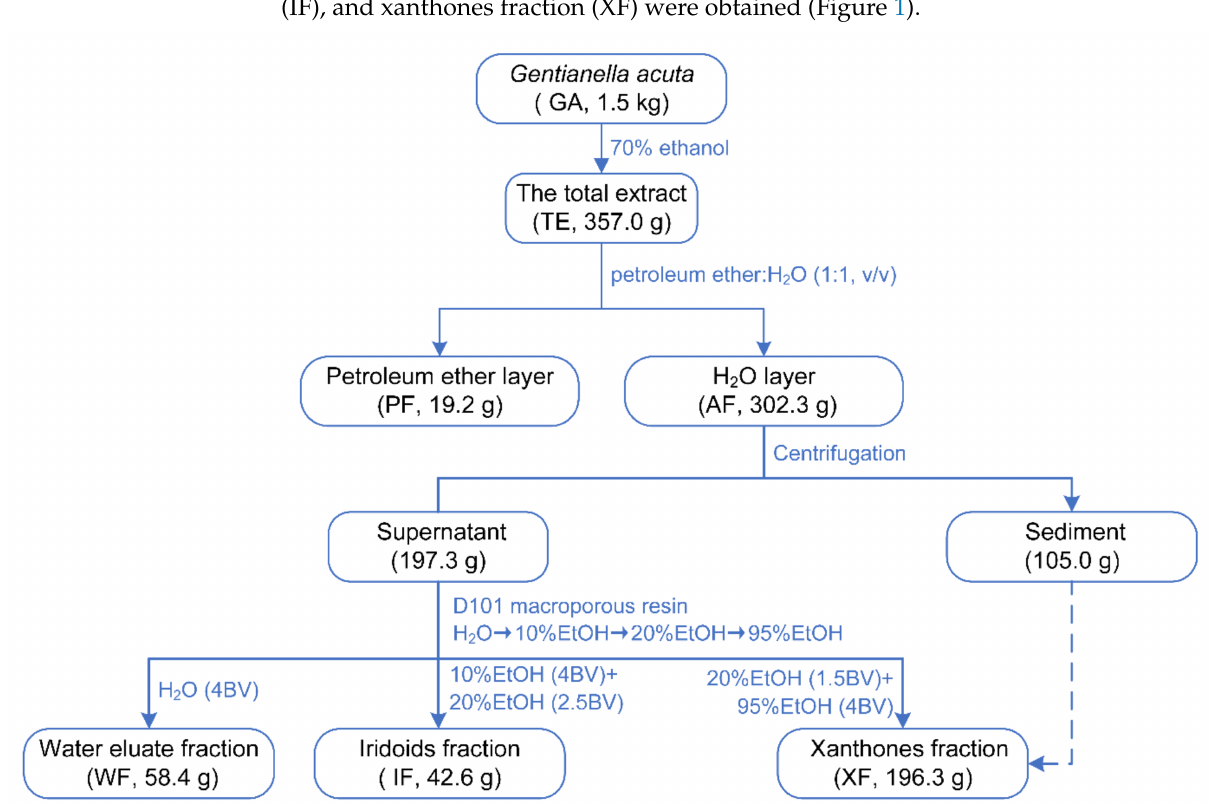
Figure 1. Extraction and separation process of G. acuta component